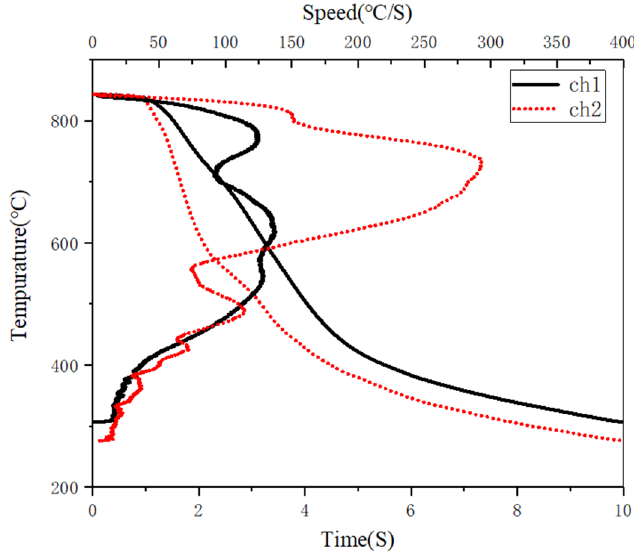
Figure 6. Calculated results of the cooling rate curves.